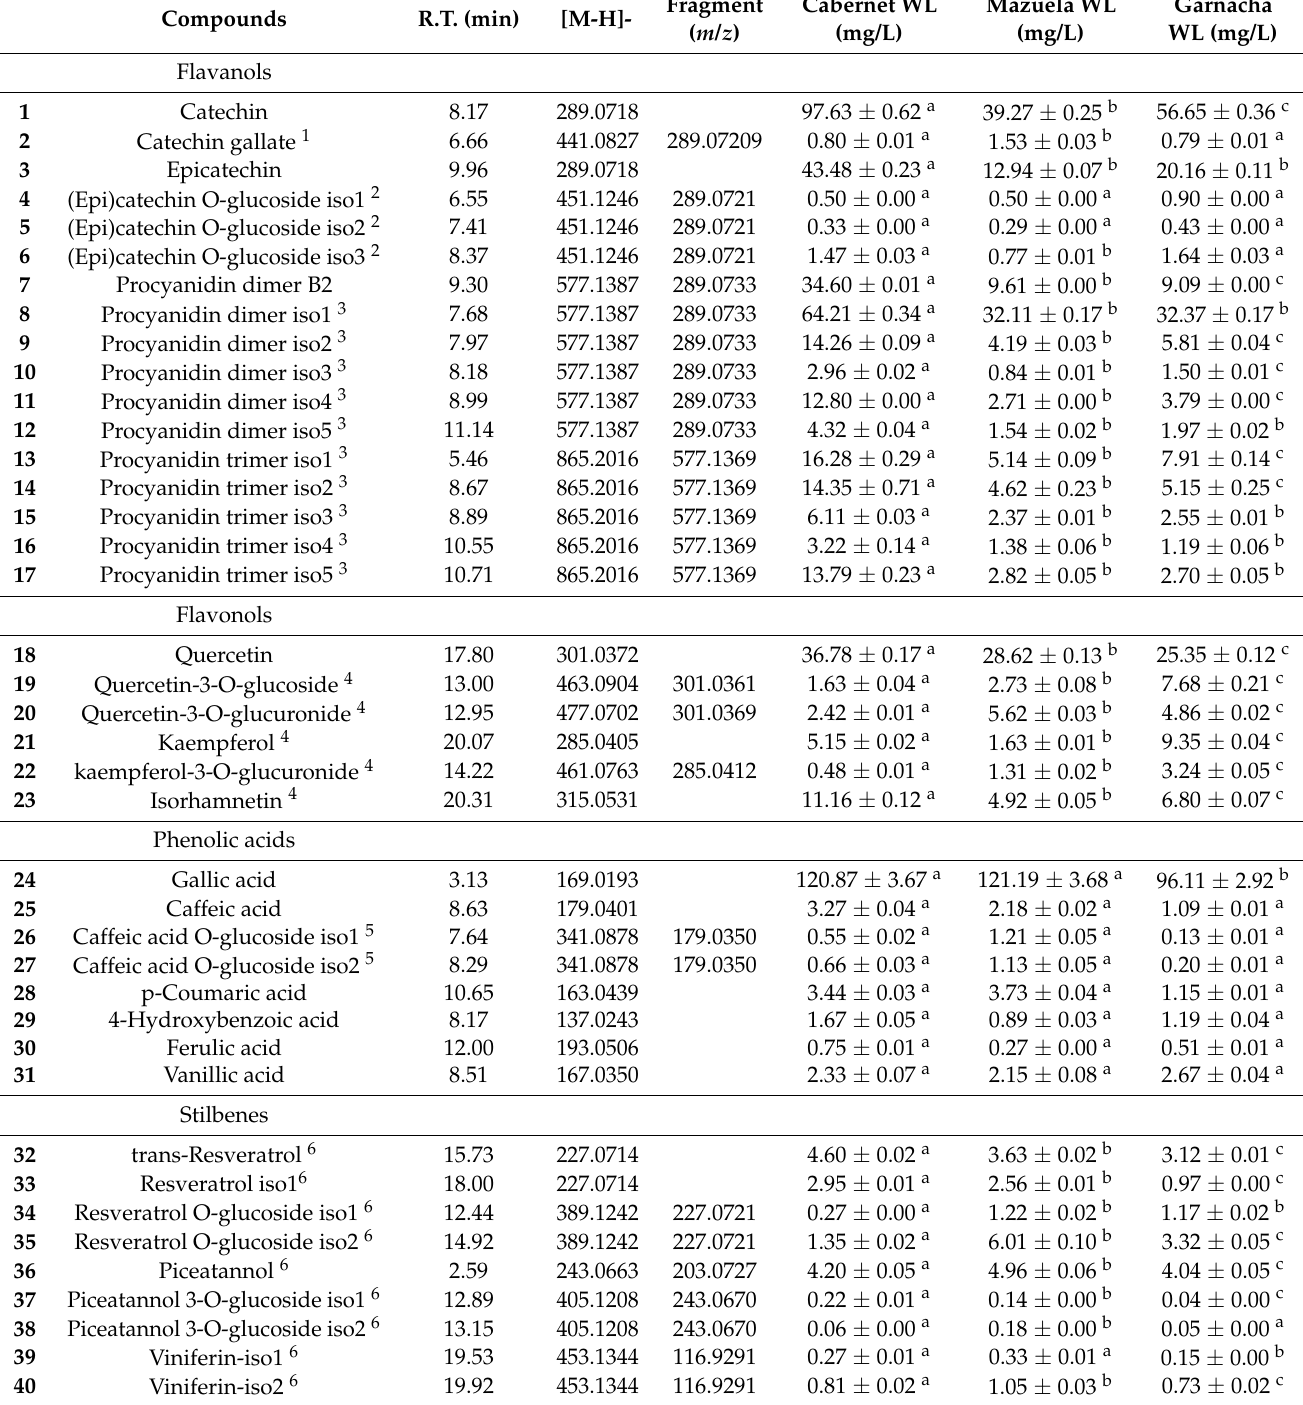
Table 3. Characterization of phenolic compounds in Cabernet, Mazuela, and Garnacha wine lees (WL) by UHPLC-(ESI-)-Q-